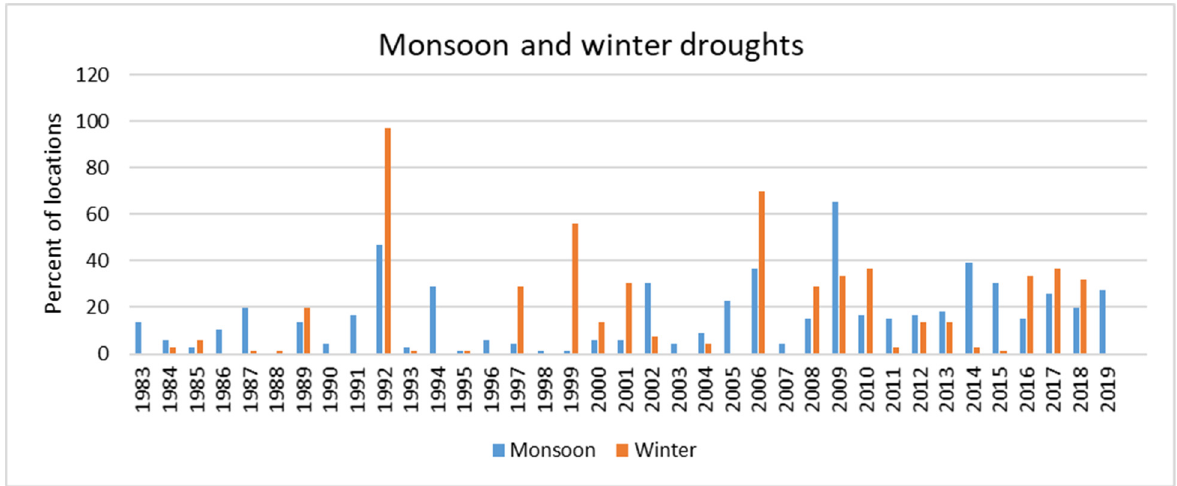
Figure 7. Winter and monsoon droughts in the Ganga–Brahmaputra Basin.